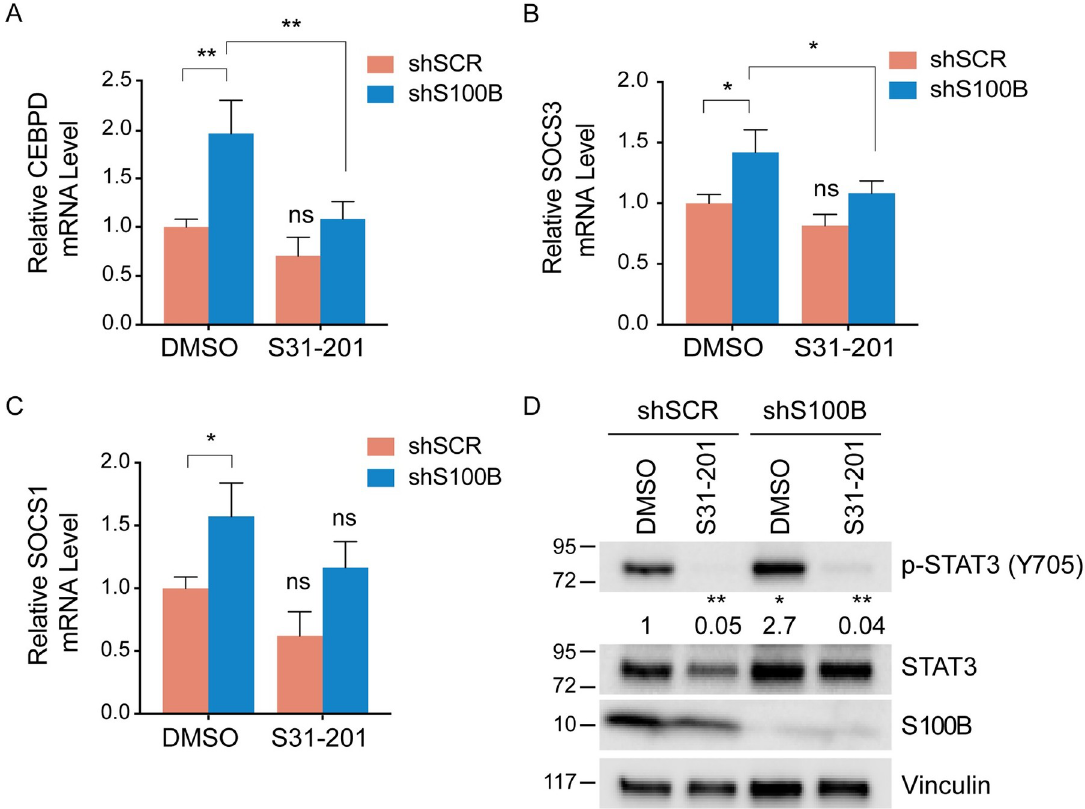
Fig 3. S100B inhibits transcription activity of p-STAT3. qRT-PCR was performed on STAT3 target genes CEBPD (A), SOCS3 (B), and SOCS1 (C) in shSCR and shS100B WM115 cells in the absence or presence of a STAT3 inhibitor S31-201 for 48 hours of treatment (100 μ M). The knockdown of S100B results in increased transcription of all three p-STAT3 regulated genes. The introduction of the STAT3 inhibitor negated that effect for CEBPD and SOCS3 but was not statistically significant for SOCS1 (P = 0.07). (n = 3; mean + SD; � , P < 0.05; �� , P < 0.005). (D) Immunoblot analysis of p-STAT3 (Tyr705) and S100B in shSCR and shS100B WM115 cells following 48 hours of S31-201 treatments (100 μ M) confirmed the loss of p-STAT3 (Tyr705). (n = 3; mean + SD; � , P = 0.05; �� , P < 0.005). Relative p-STAT3 protein levels were quantified using Image J